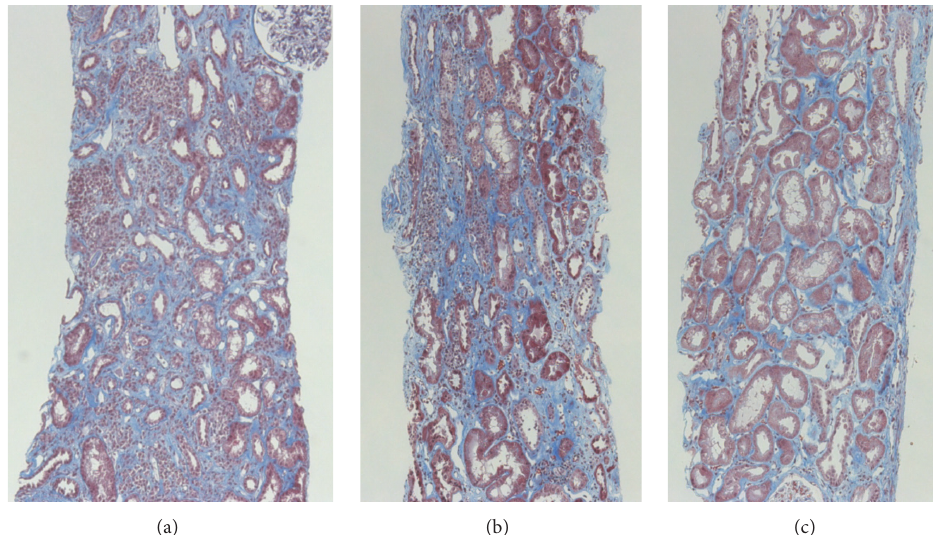
Figure 4: Time-dependent histopathological changes in tubulointerstitial lesions at 3 (a), 6 (b), and 12 months (c) after transplantation ((a–c) Masson’s Trichrome, × 100). Light microscopic findings revealed marked regression of plasma cell infiltration at 12 months, compared with at 3 or 6 months after